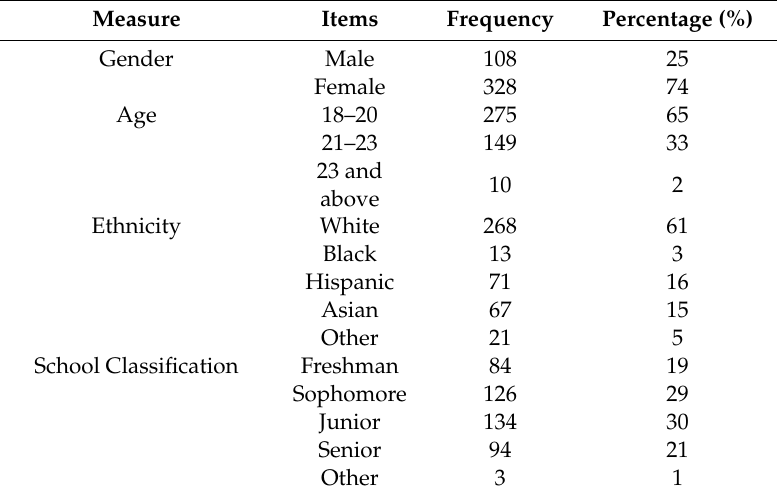
Table 1. Demographic information of the